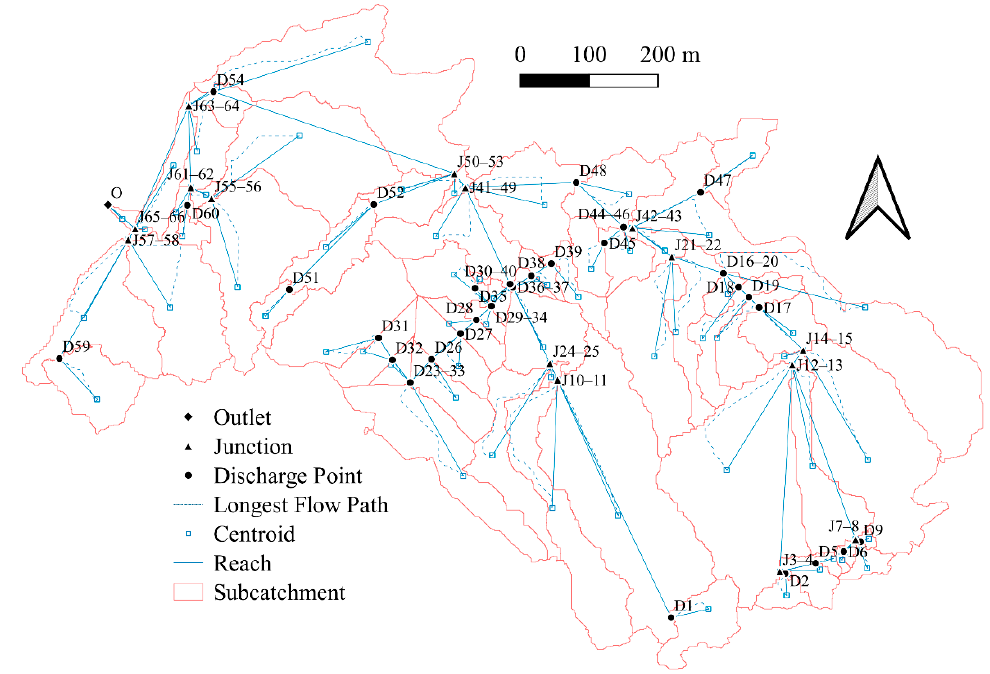
Figure 5. Schematic representation of the nodes (junctions and discharge points) in the Monte- Corbanera catchment.